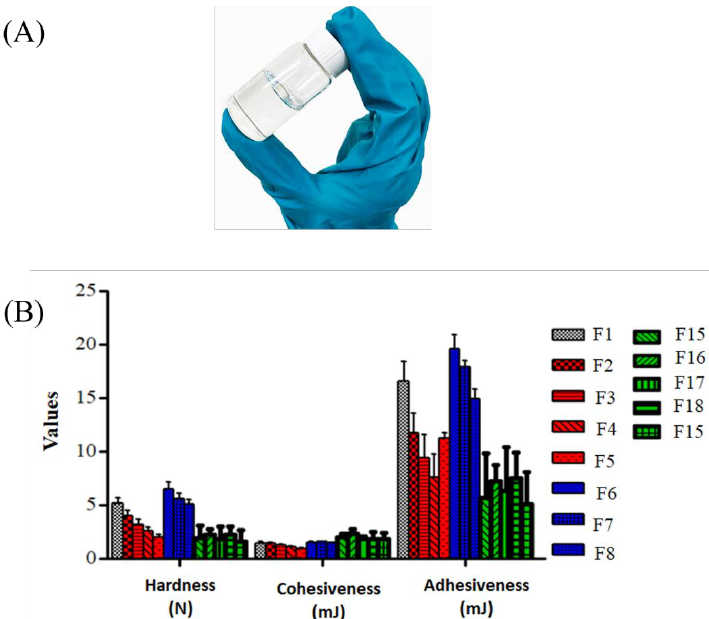
Figure 1. ( A ) Physical appearance of Pluronic PF127 gel at ambient temperature. ( B ) Texture profile analysis (TPA) of thermoresponsive gels of different formulations and containing natural extracts, n =